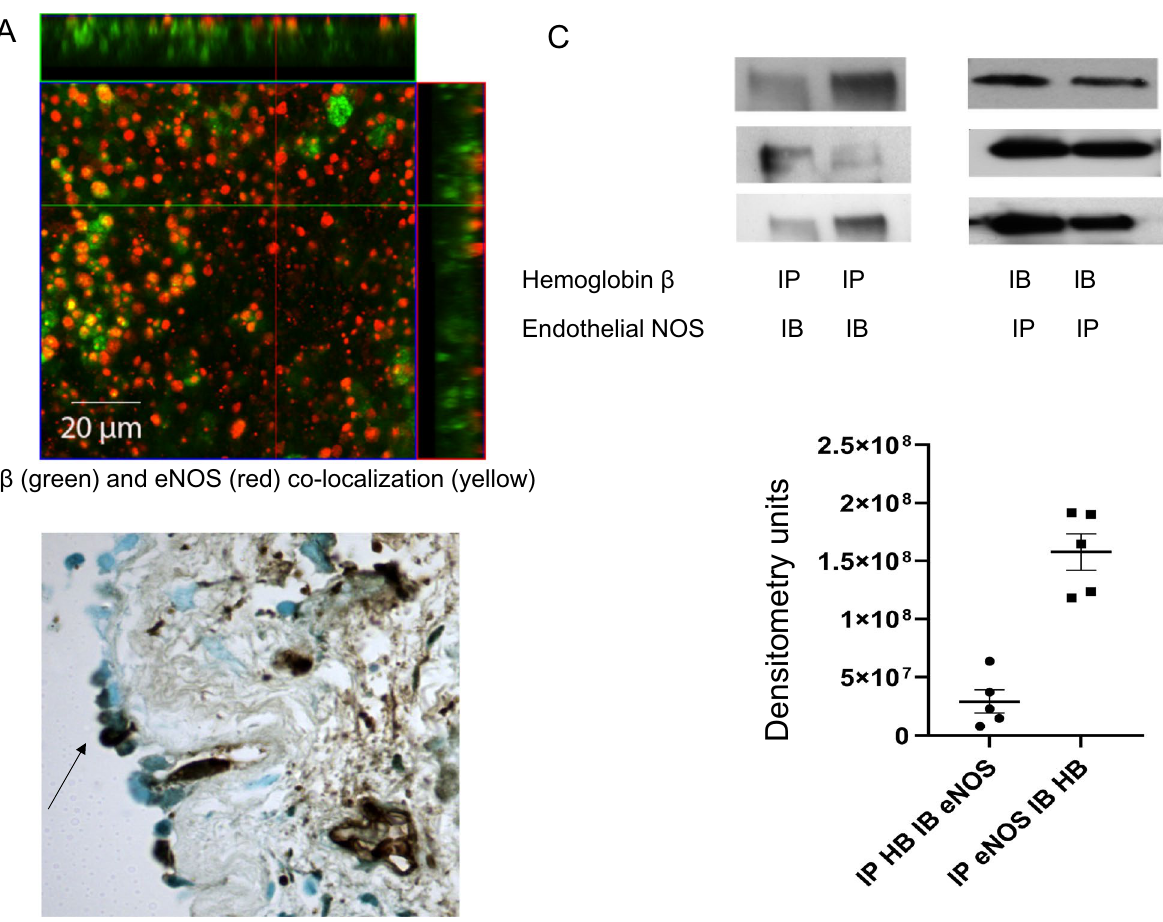
Figure 5. Hemoglobin β is colocalized with endothelial nitric oxide synthase (eNOS) in normal human airway epithelial cells. ( A ) Immunofluorescent staining of Hbβ (green) and eNOS (red) are co-localized (yellow) in primary airway cells NHE grown on ALI, permeabilized, fixed and labeled as described in the methods. Studies were performed by confocal microscopy, Leica, 60X. ( B ) Immunohistochemical staining of Hbβ in an endobronchial biopsy from a healthy subject in the SARP. Normal lung biopsy revealed presence of Hbβ at the apex of airway epithelial cells (arrow) and some in inflammatory cells, × 40 magnification. ( C ) Colocalization of eNOS and Hbβ in normal human airway epithelial cell cultures. Cell cultures at ALIs were lysed in RIPA buffer and immunoprecipitated (IP) for Hbβ followed by immunoblot (IB) for and eNOS (left panel); in separate cells, proteins were IP’d for eNOS followed by IB for Hbβ (right panel). Immunoprecipation and IB were performed as described in the methods, total. N =